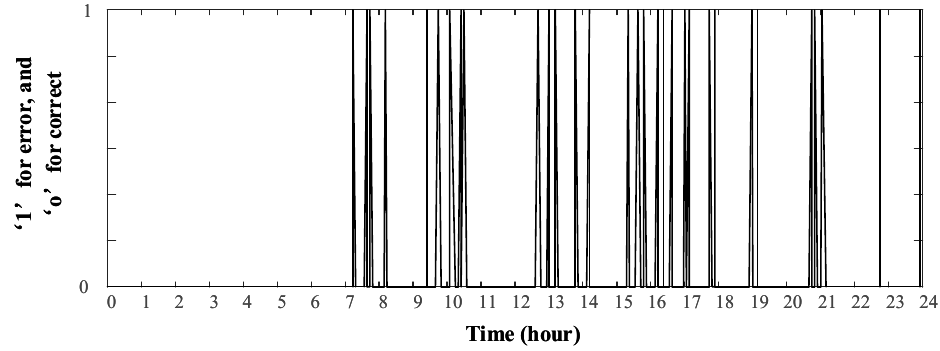
Figure 9. The CHP control algorithm errors in sampling date.